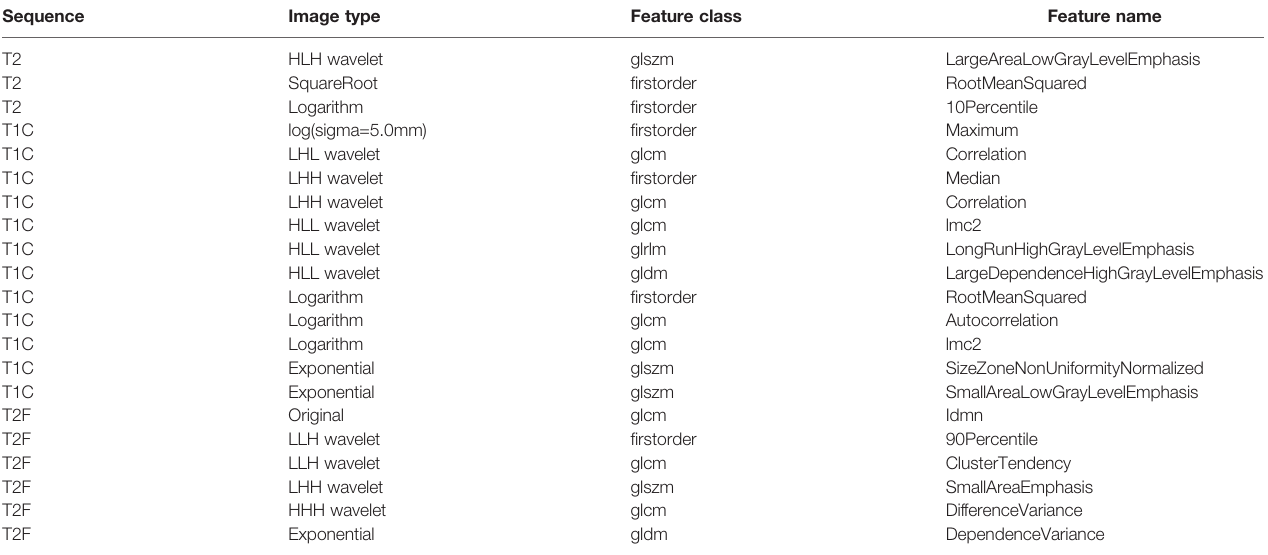
TABLE 2 | Description of the radiomics features